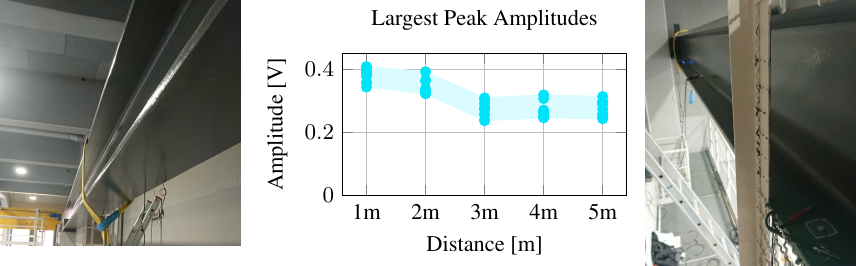
Figure 17. Experiment on a large structure with transducers placed at distances 1, 2, 3, 4, and 5 m. The graph shows the amplitudes of the ten best frequencies over different